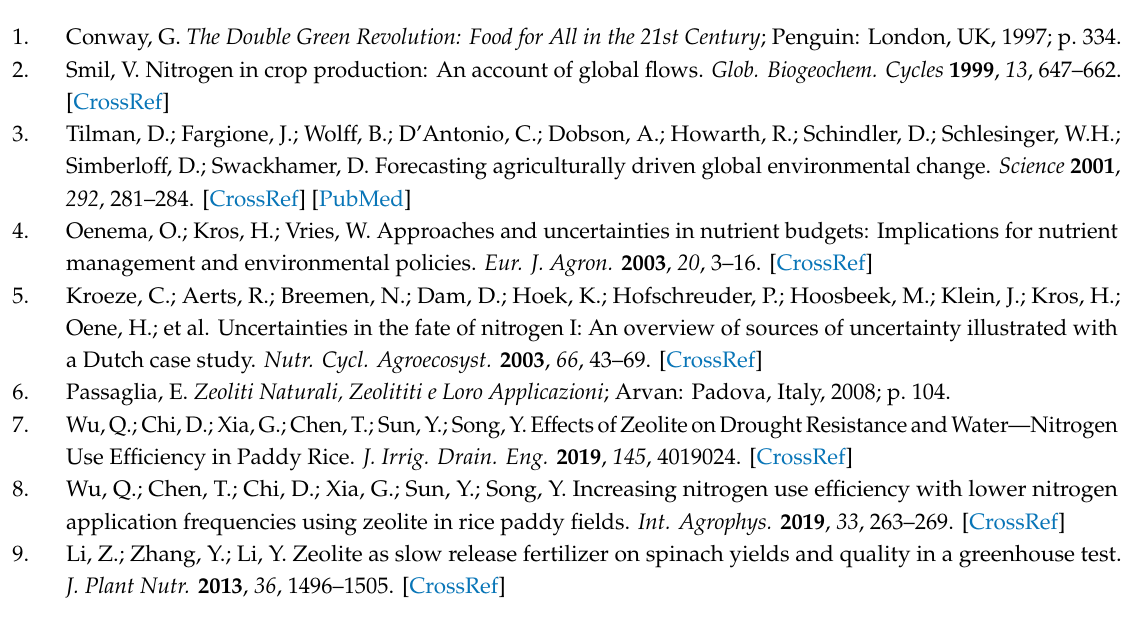
Table S1: Average of N and C pools. Table S2: Average of TN, TOC and C / N of sorghum